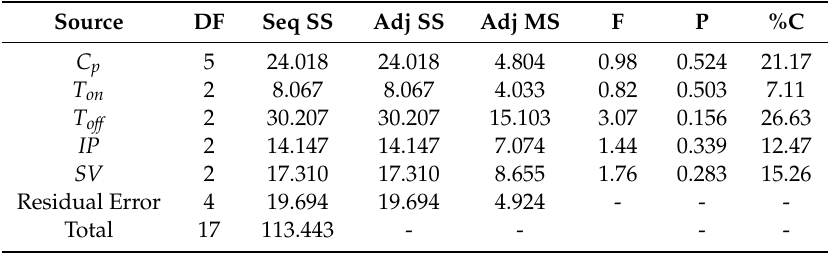
Table 5. ANOVA for R a